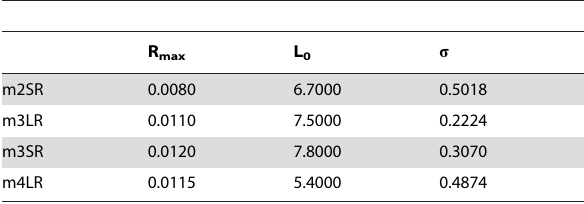
Table 1. Parameters for the R(L) function in each muscle.